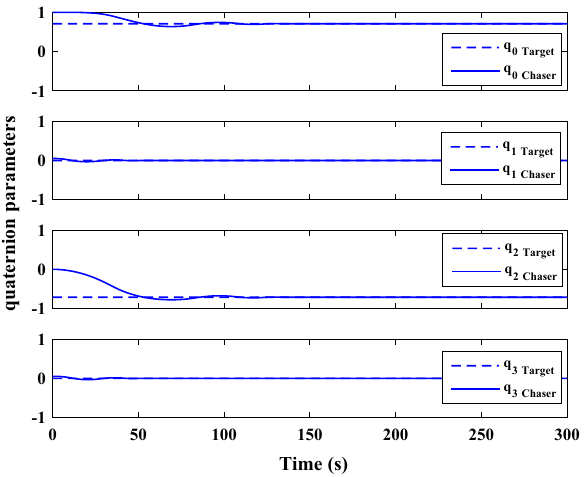
Figure 16. Scenario I: quaternion parameters tracking.